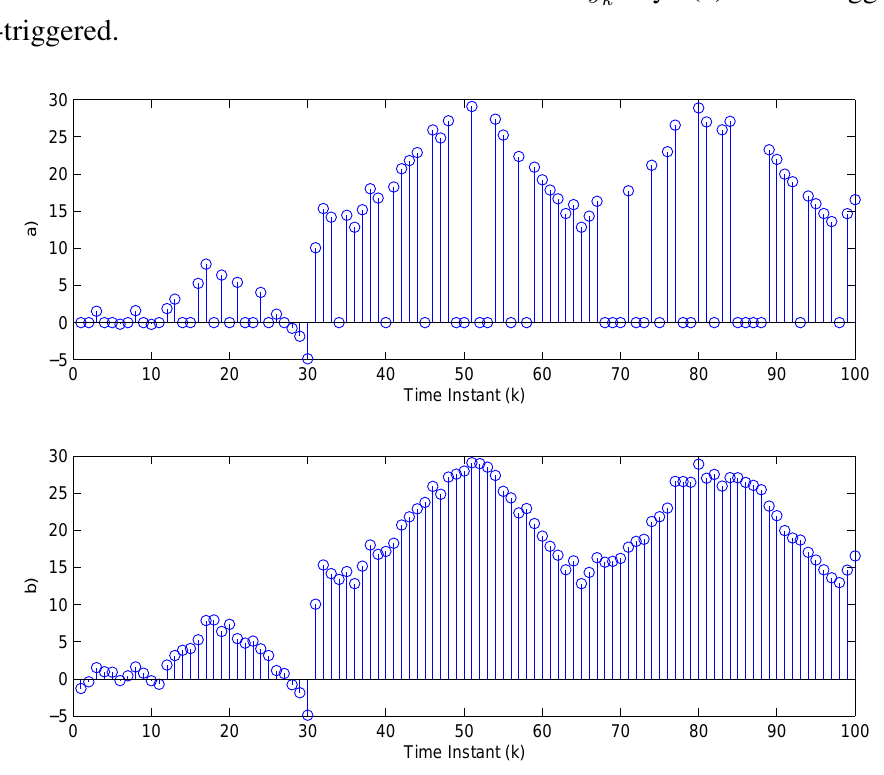
by (a) event-triggered and k